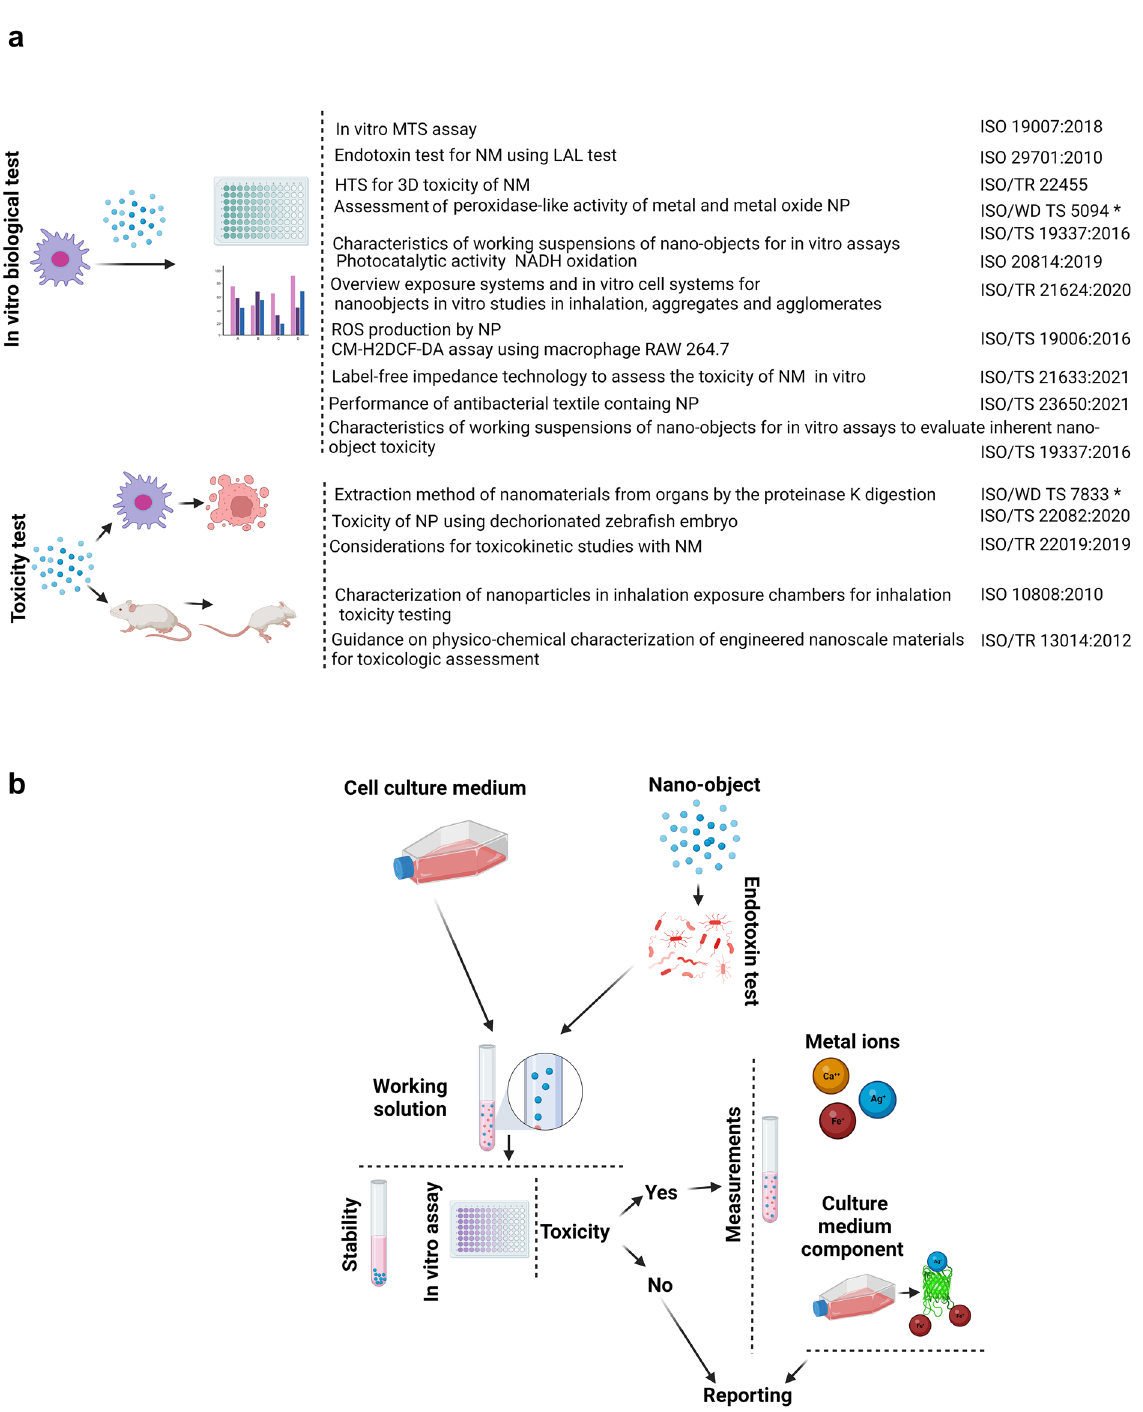
Fig. 3 Examples of standards related to the in vitro biological tests and toxicity evaluations/monitoring of nanomaterials. a ISO (TC) 229 com- mittee standards provide general guidelines and recommendations for nanoparticle characterization in biological environments, and for evalu- ation of nanoparticle biocompatibility in living systems. Standard labeled by “*” are currently under development. b Schematic showing the states at which measurements are made (Technical Specification ISO/TS